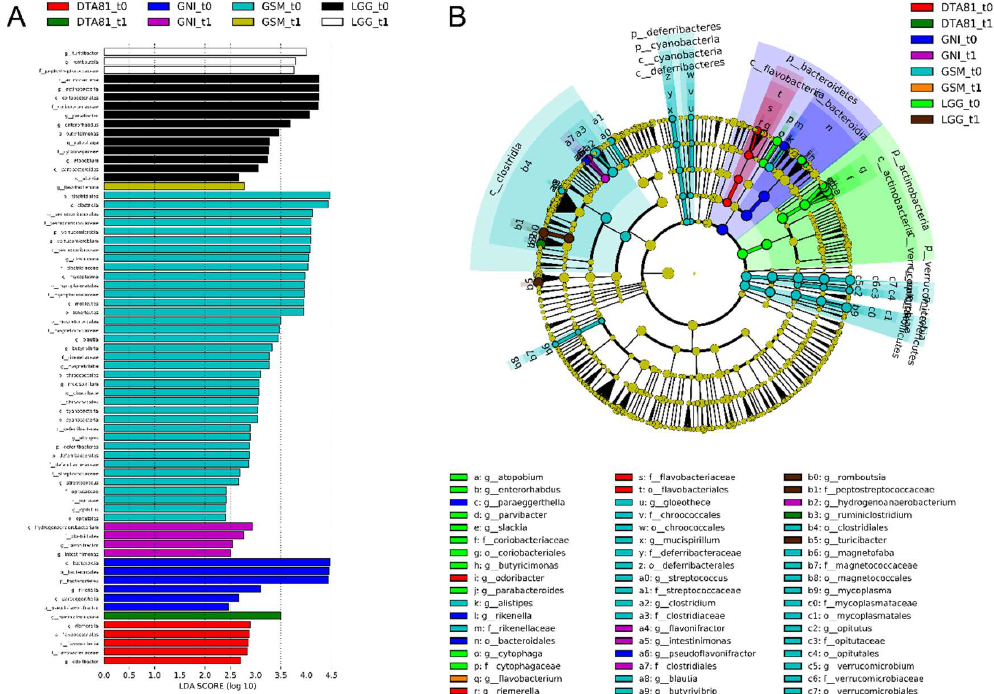
Figure 7. Linear discriminant analysis effect size (LEfSe) analysis to identify significant differences in abundant taxa (biomarkers) before ( t 0) and after ( t 1) the different interventions. ( A ) Taxonomic groups showing linear discriminant analysis (LDA) scores > 2.0 with false discovery rate (FDR) p < 0.05. Letters: p , phylum; c, class; o, order; f, family; g, genus. ( B ) Cladogram showing taxa with different abundance among the groups (LDA score > 2.0, FDR p < 0.05). Letters have the same equivalence to those in parentheses in ( A ).